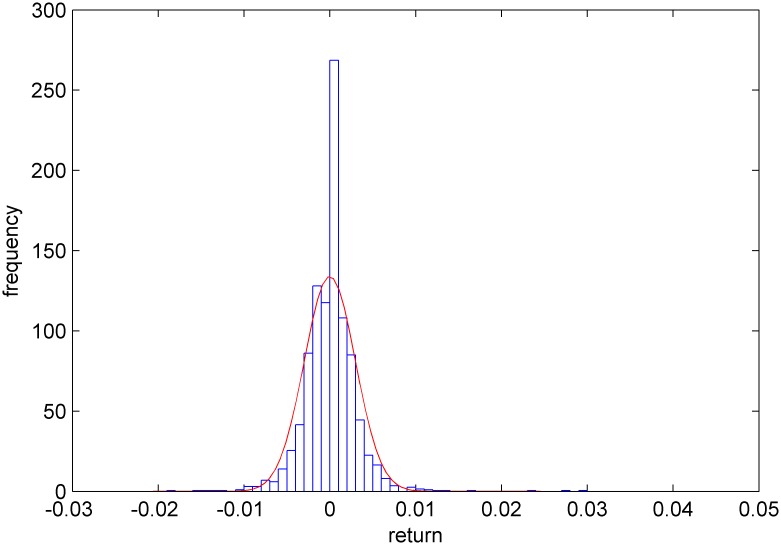
The yield distribution fitting diagram of China Television Media.